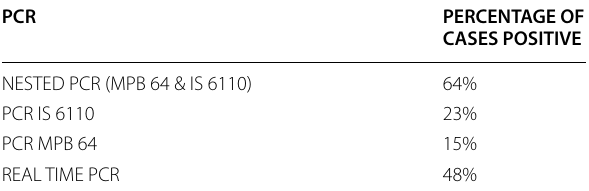
Table 1 PCR for MTB results of intraocular fluids of